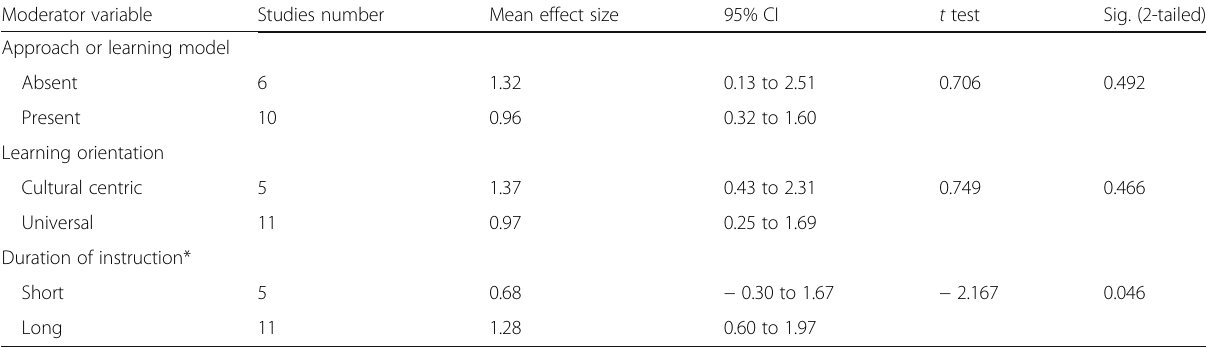
Table 3 Moderator variable analysis of higher-order thinking skills